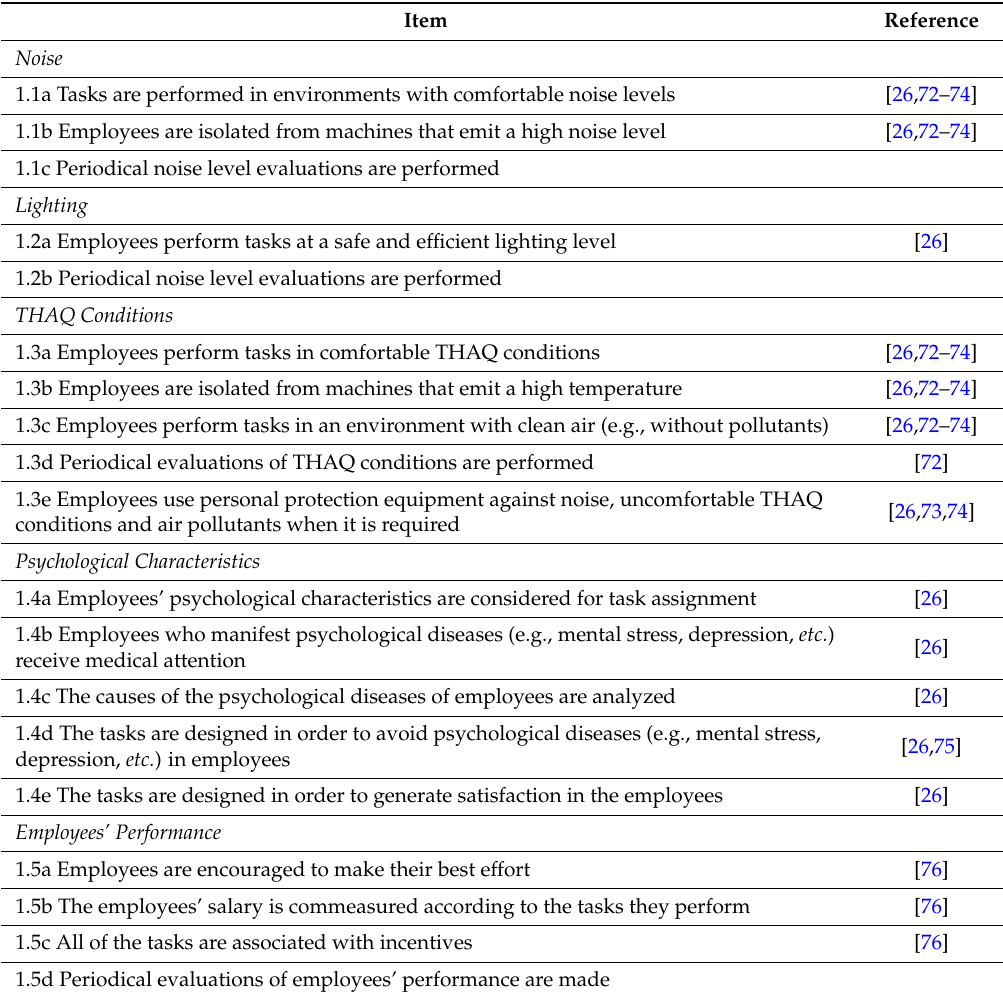
Table 1. References for the macroergonomic compatibility questionnaire (MCQ) items.